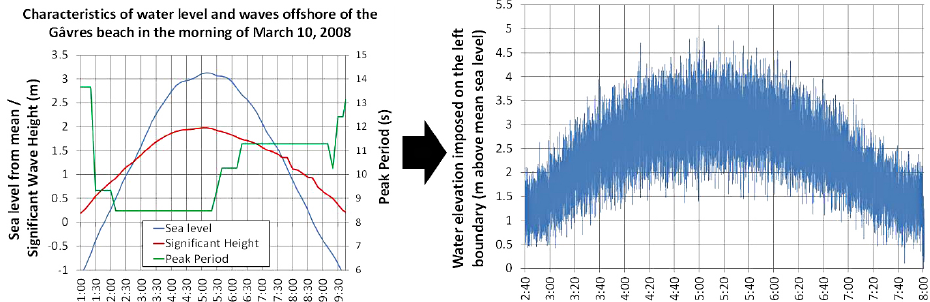
Figure 6. Evolution of the sea conditions near Gâvres during the Johanna storm (sea level from MARS simulations, significant wave height and peak period from SWAN simulations) on the left, and reconstitution of a corresponding time series of water level with the DIWASP toolbox on the